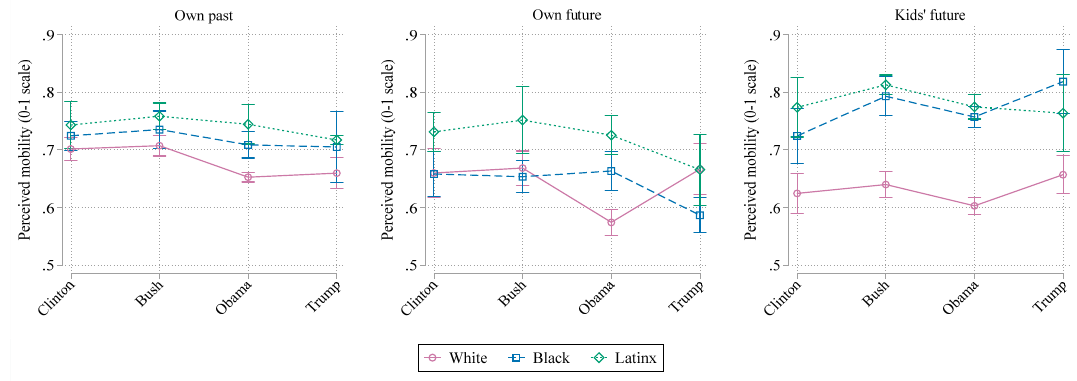
Figure 1. Perceived mobility, by race and presidential administration (unadjusted). Confidence intervals are at the 95% level.